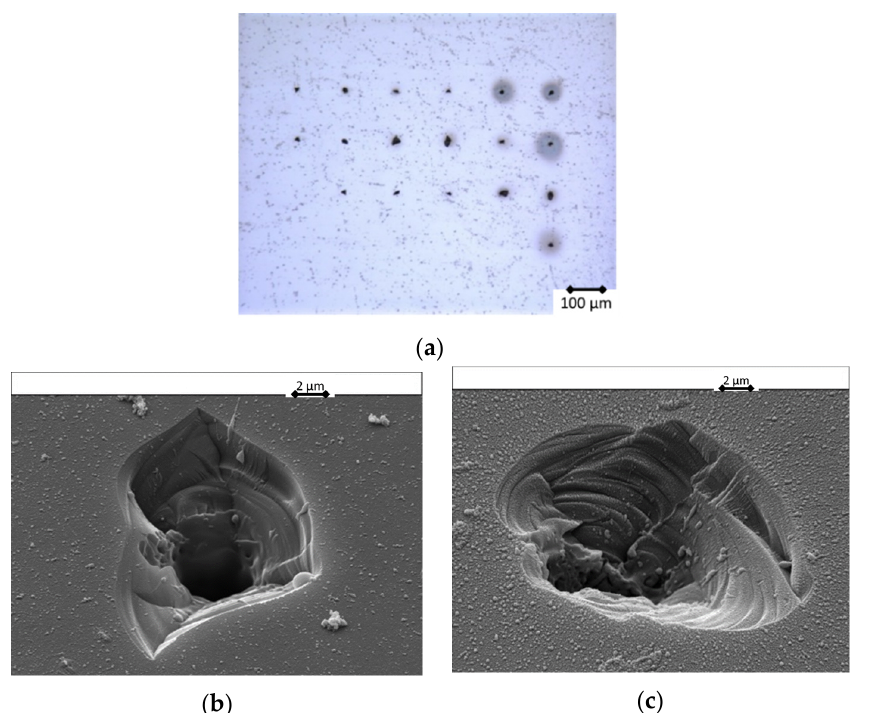
Figure 3. ( a ) Optical micrograph of the laser-modified sites on the surface of fused silica glass, ( b ) SEM micrograph for the surface modification of fused silica glass at 10 pulses at 72 Jcm − 2 , and ( c ) SEM micrograph for surface modification of fused silica glass at 50,000 pulses at 72 Jcm − 2 .